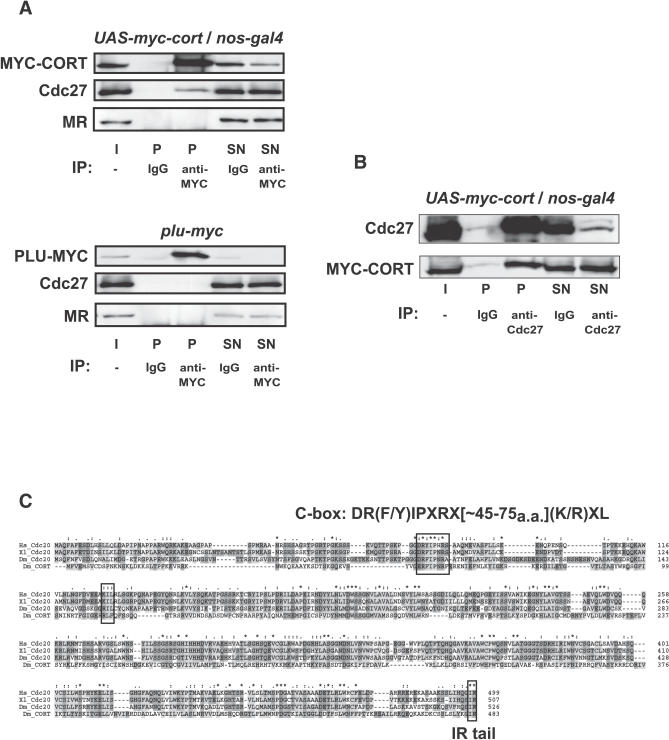
CORT Protein Associates with the APC/C In Vivo(A) Cdc27 co-immunoprecipitates with MYC-CORT. Top panel: MYC-CORT was immunoprecipitated from whole ovary extracts from UAS-myc-cort/nos-gal4 females with anti-MYC or control mouse IgG, and immunoprecipitates were examined for the presence of APC/C subunits, Cdc27 and MR/APC2. Bottom panel: Unrelated MYC-tagged control PLU-MYC was immunoprecipitated from whole ovary extracts from plu-myc transgenic females with anti-MYC or control mouse IgG, and immunoprecipitates were examined for the presence of APC/C subunits. I, input; P, pellet; SN, supernatant.(B) MYC-CORT co-immunoprecipitates with Cdc27. Cdc27 was immunoprecipitated from whole ovaries from UAS-myc-cort/nos-gal4 females with anti-Cdc27 or a control rabbit IgG, and immunoprecipitates were examined for the presence of MYC-CORT.(C) CORT contains motifs conserved in the Cdc20/FZY family of proteins. CORT protein sequence was hand aligned with Cdc20/FZY protein sequences from human (Hs), Xenopus (Xl), and Drosophila (Dm). The conserved internal C-box and C-terminal IR (isoleucine-arginine) tail are boxed. *, identity; :, high similarity; ., some similarity.